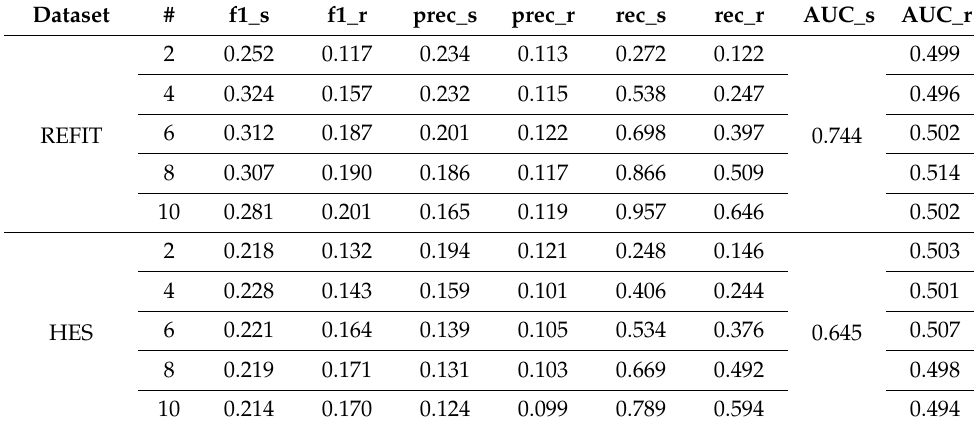
Table 3. Seven day-single appliance (dishwashers).